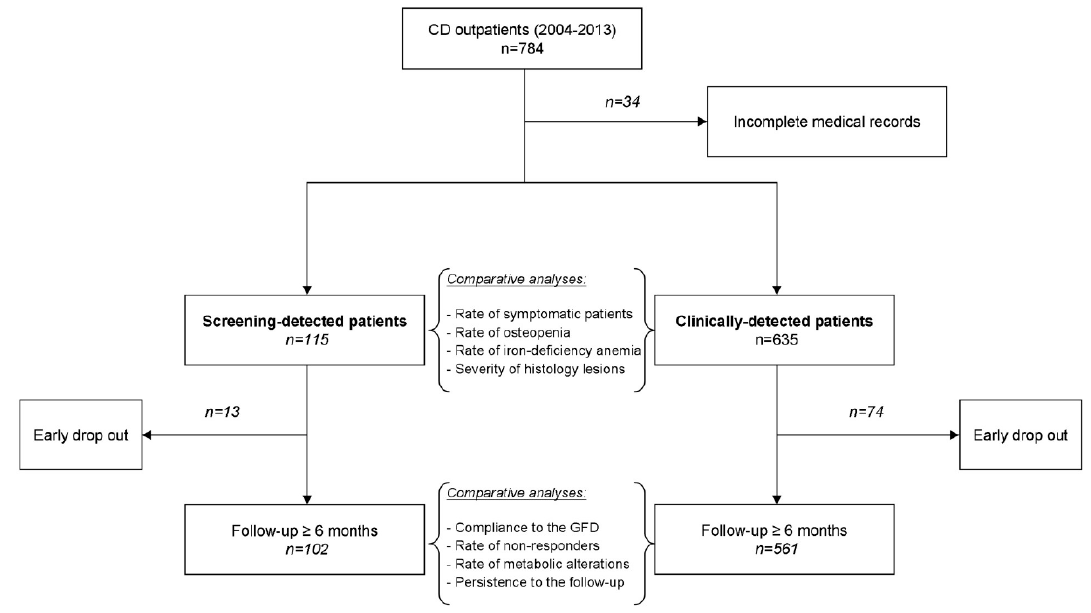
Figure 1. Patients’ flow chart. CD: celiac disease